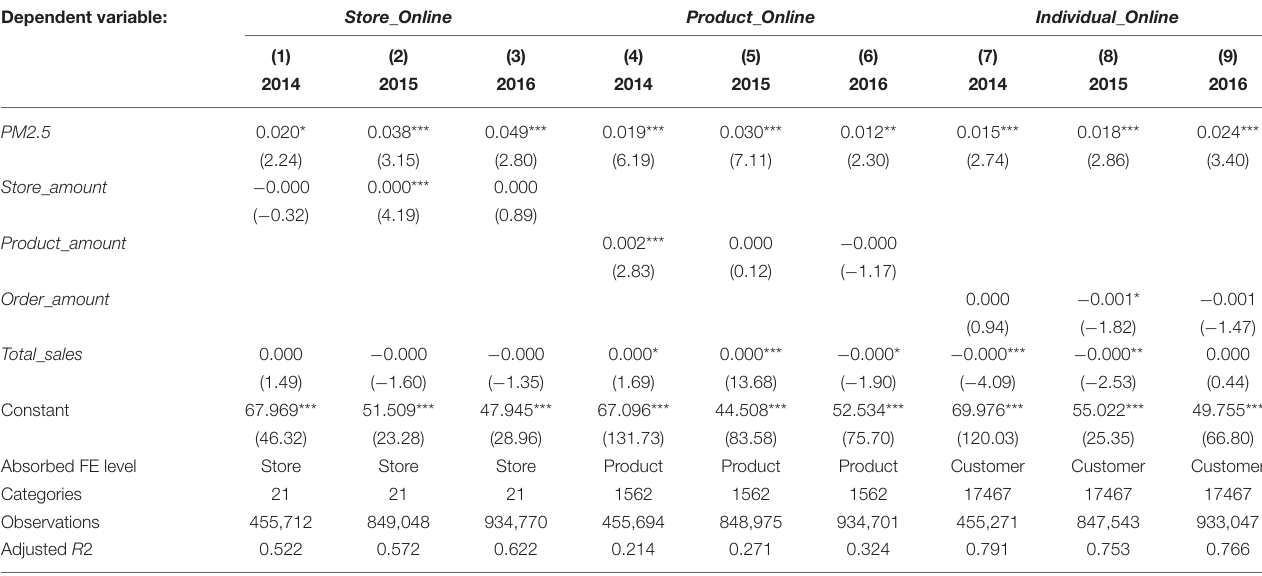
TABLE 8 | Subsample results by year.